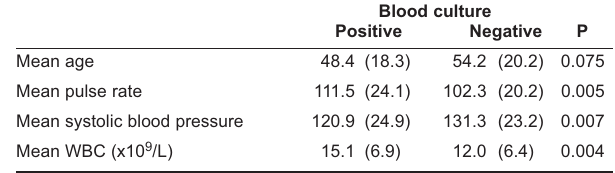
TABLE 4 Comparison of selected physical findings and laboratory data for patients with positive and negative blood cultures